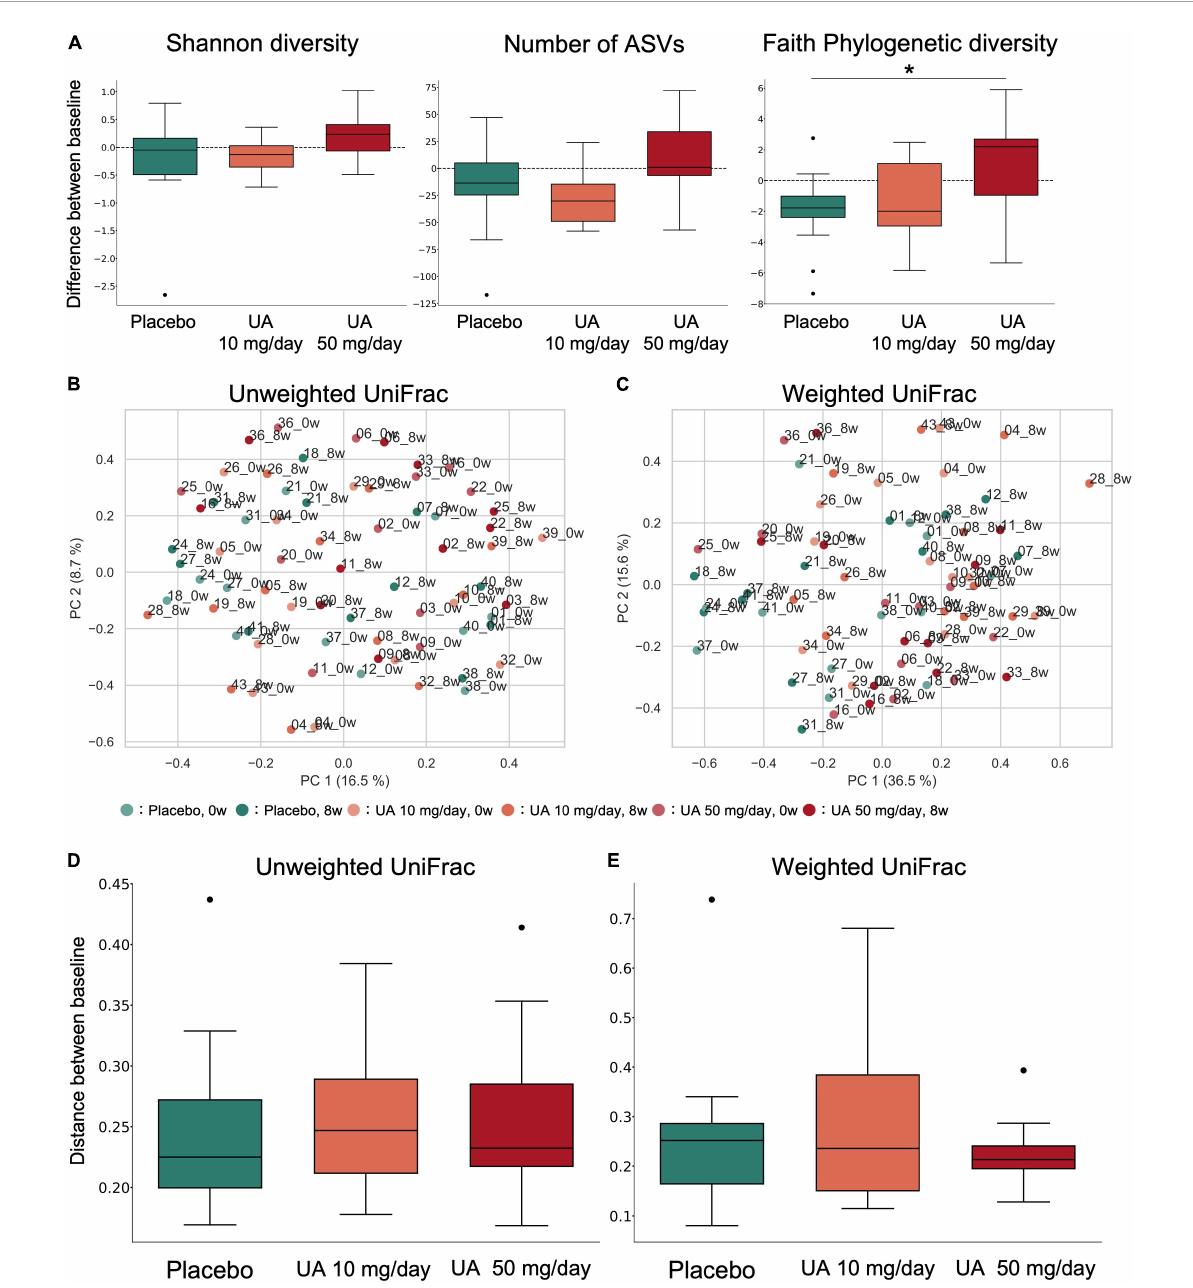
FIGURE2 α - and β -diversity of the gut microbiota. (A) Box plot of alpha diversity indices of gut microbiota profiles (left: Shannon diversity; middle: number of ASVs; right: Faith’s phylogenetic diversity). * p < 0.05; Dunn’s tests. (B,C) Principal coordinate analysis was performed on the samples’ (B) unweighted UniFrac distance or (C) weighted UniFrac distance. This percentage represents the contribution ratio. (D,E) The (D) unweighted UniFrac distance and (E) weighted UniFrac distance were calculated for each participant between 0 and 8 weeks of UA intake and are shown as box plots for each group. Kruskal–Wallis tests were performed between groups; however, no significant differences were detected. UA, urolithin A; ASV, amplicon sequence variant.